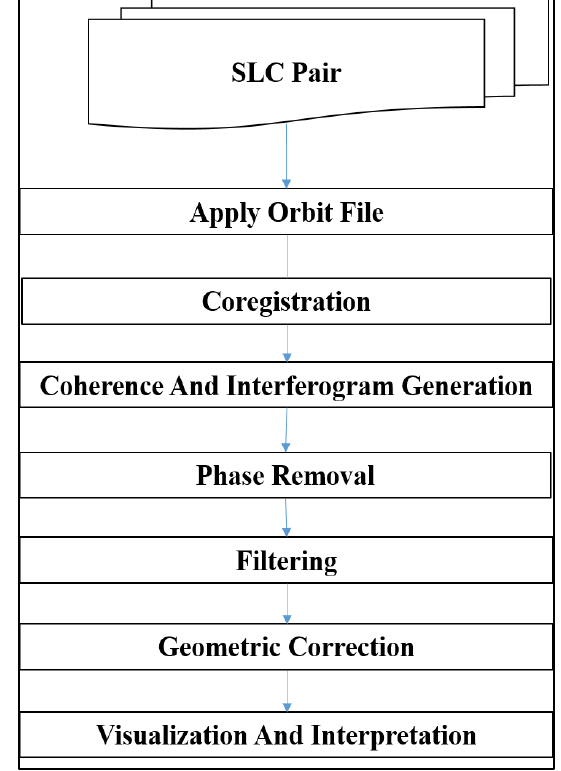
Figure 2 Methodology flow chart